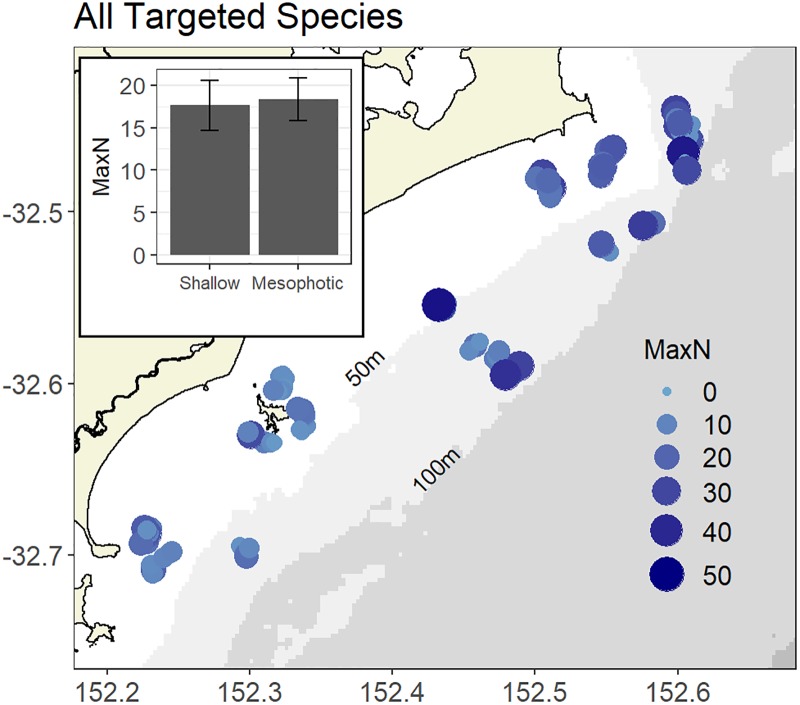
The spatial distribution of fishery targeted species.Distribution of all commercial and recreationally targeted species as observed by stereo-BRUVs across the study area. Bubble size and colour represents the MaxN of all commercial and recreationally targeted species for each individual stereo-BRUV deployment. Inset plot: Mean (+/- SE) MaxN of all commercial and recreationally targeted species across shallow and mesophotic reef.